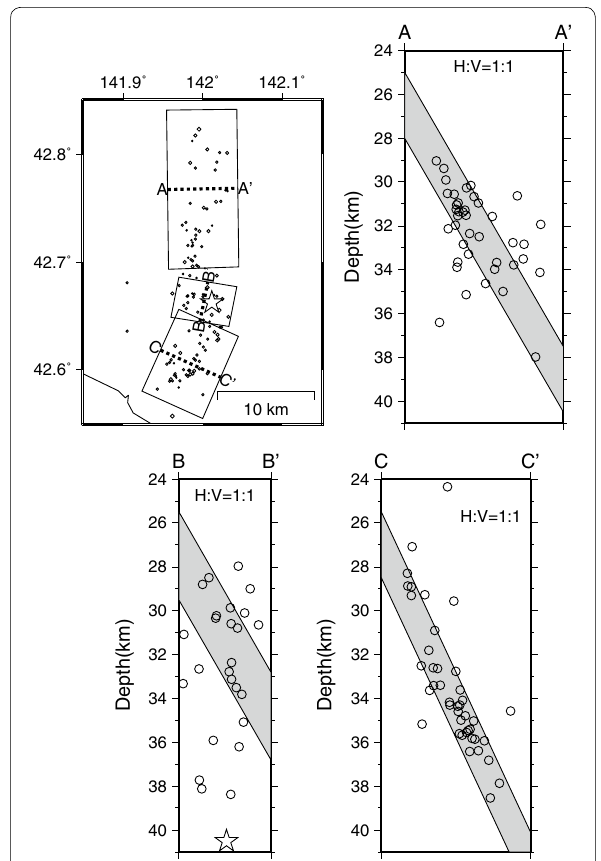
Fig. 3 Vertical cross sections in the northern segment (A–A’), in the stepover segment (B–B’), and in the southern segment (C–C’). All sections have no vertical exaggeration. A total of 118 aftershocks were selected from the hypocenters in Fig. 2a from 2018-09-06 03:15 to 2018-09-06 09:00. Shaded areas indicate zones with dip angles of 60°, 60°, and 65° in the A–A’, B–B’, and C–C’ sections,